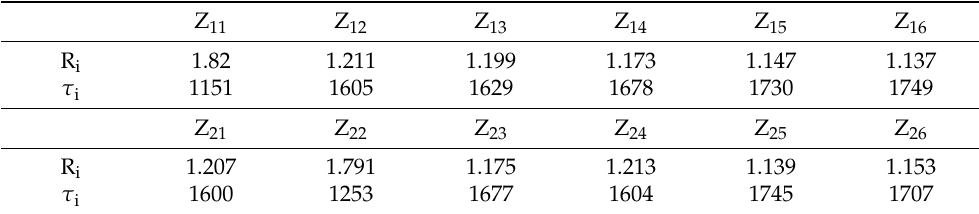
Table 1. Curve-fitted resistances and time constants associated with thermal impedances Z 1 i and Z 2 i ( i = 1, . . . 6).